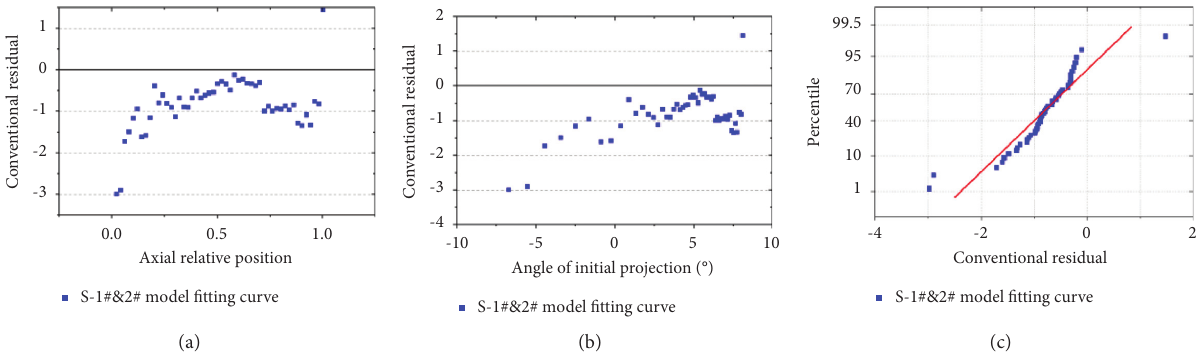
Figure 13: Error analysis for verifying the model. (a) Axial relative position error. (b) Dispersion distribution error. (c) Percentile error.